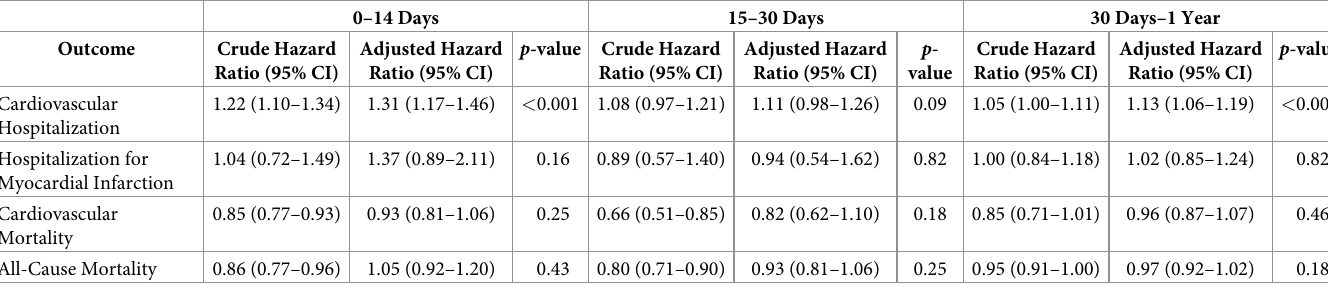
Table 3. Association of clarithromycin and cardiovascular risk versus amoxicillin in the observational